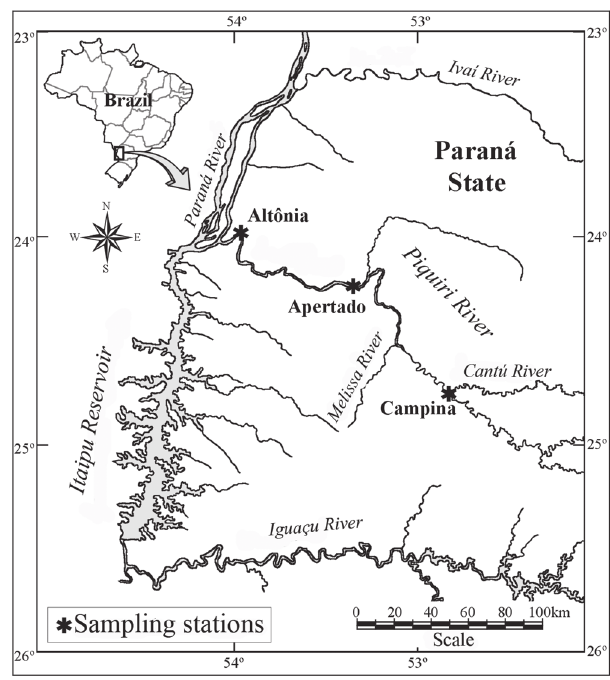
Fig. 1 . Localization of the sampling sites in the Piquiri